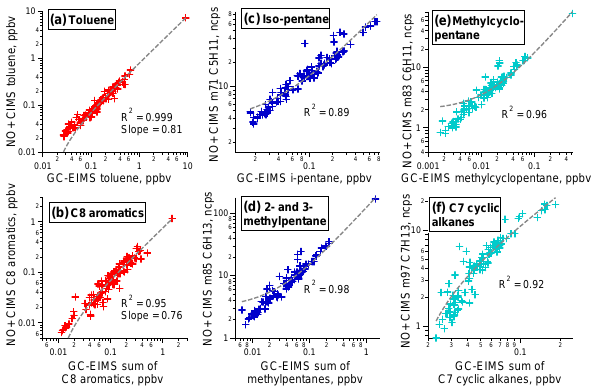
Figure 10. Correlations between VOCs measured with GC-EIMS and NO + ToF-CIMS in ambient air. The 1Hz NO + ToF-CIMS measurement is averaged to the 5min GC collection period. Or- thogonal least-squares linear best fits (ODR best fit) are shown with dashed lines. The lines appear curved due to log-scale axes. For several compounds (e.g., methylcyclopentane, 2- and 3- methylpentane), the single high outlier pulls the best fit slightly away from the data points at low mixing ratios. (a) Toluene. (b) C 8 aromatics: sum of ethylbenzene, o-xylene, m-xylene, and p-xylene. (c) Isopentane. (d) Sum of 2-methylpentane and 3-methylpentane. (e) Methylcyclopentane. (f) C 7 cyclic alkanes: sum of methylcyclo- hexane, ethylcyclopentane, and dimethylcyclopentane.